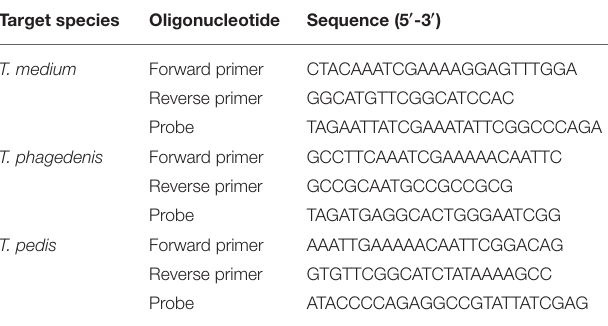
TABLE 1 | Primer and probe oligonucleotide sequences used in the Taqman qPCR assays targeting the RecA gene of T. medium , T. phagedenis , and T. pedis